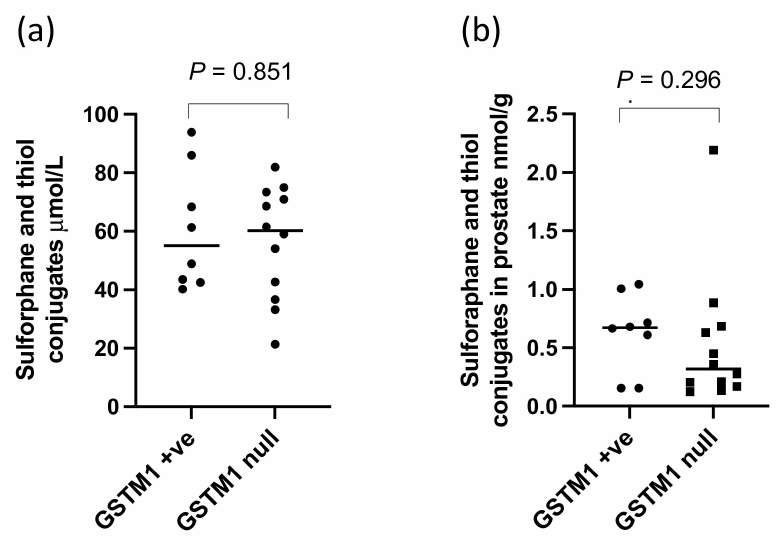
Figure 5. Sulforaphane and thiol conjugates in ( a ) urine and ( b ) prostate of GSTM1 +ve and null participants following GRN supplementation. p -values are from Mann–Whitney tests.